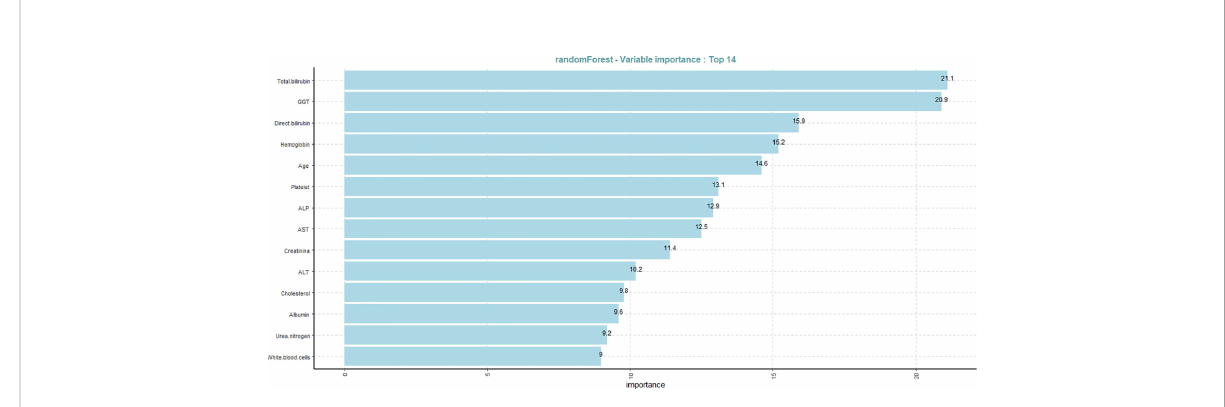
FIGURE 2 Variable importance plot of the 14 risk factors of liver disease based on the random forest